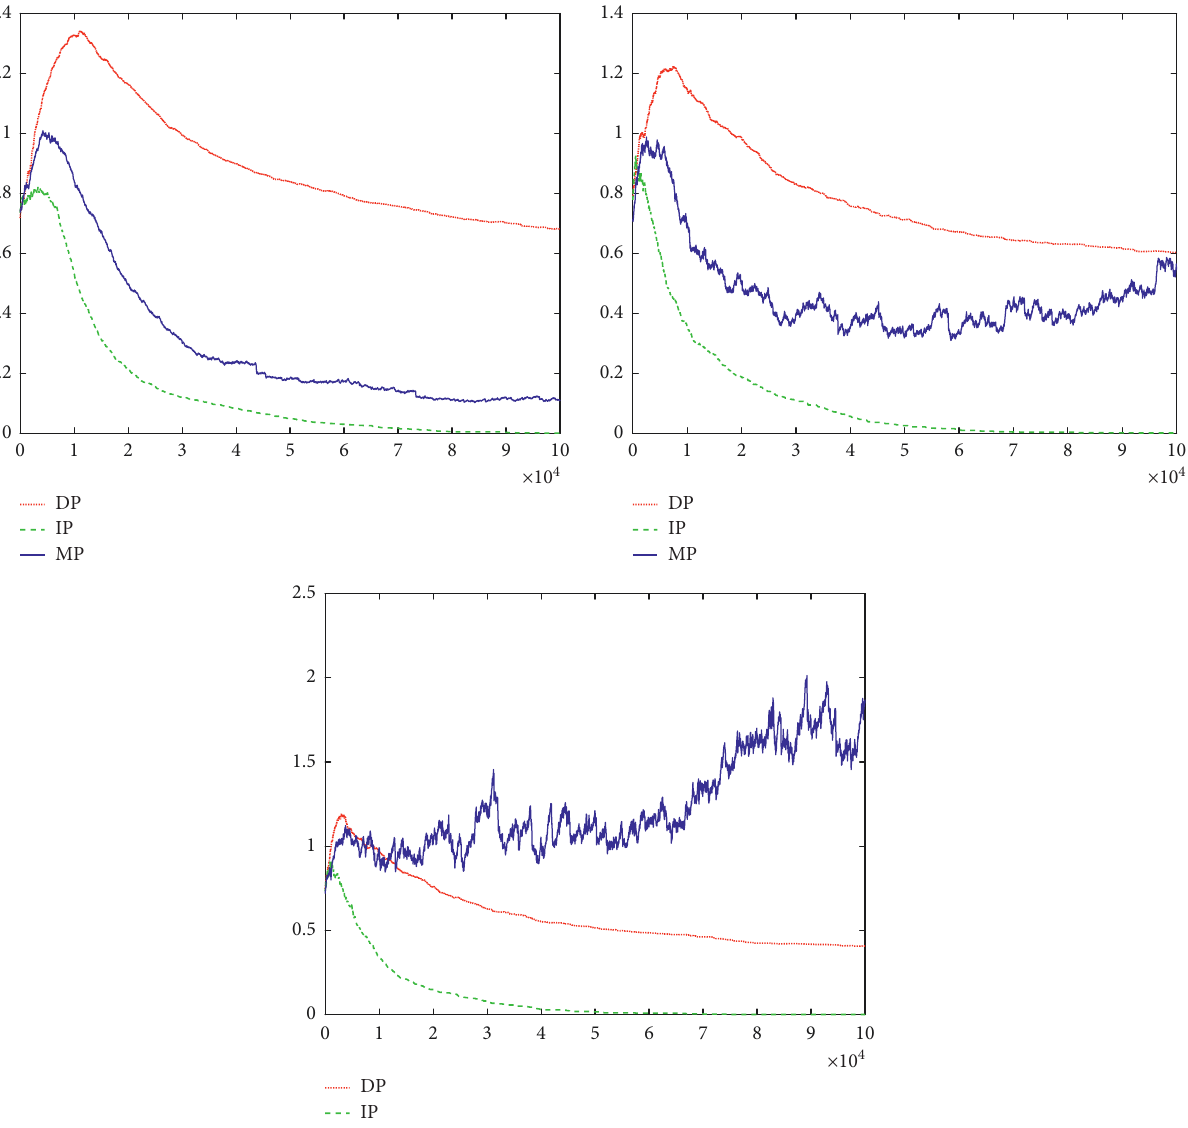
Figure 7: Knowledge equilibrium in a scale-free network when L � 2, 6, and